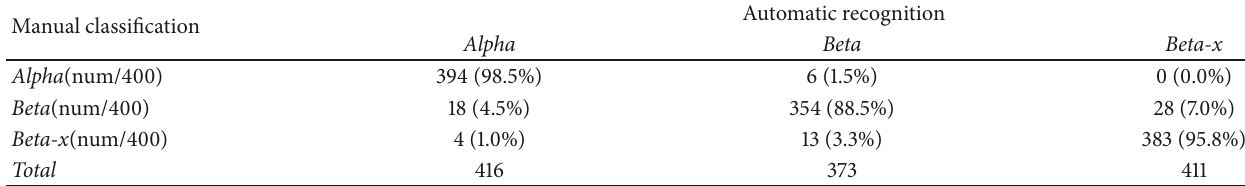
Table 6: Details of Model B Classification Results.